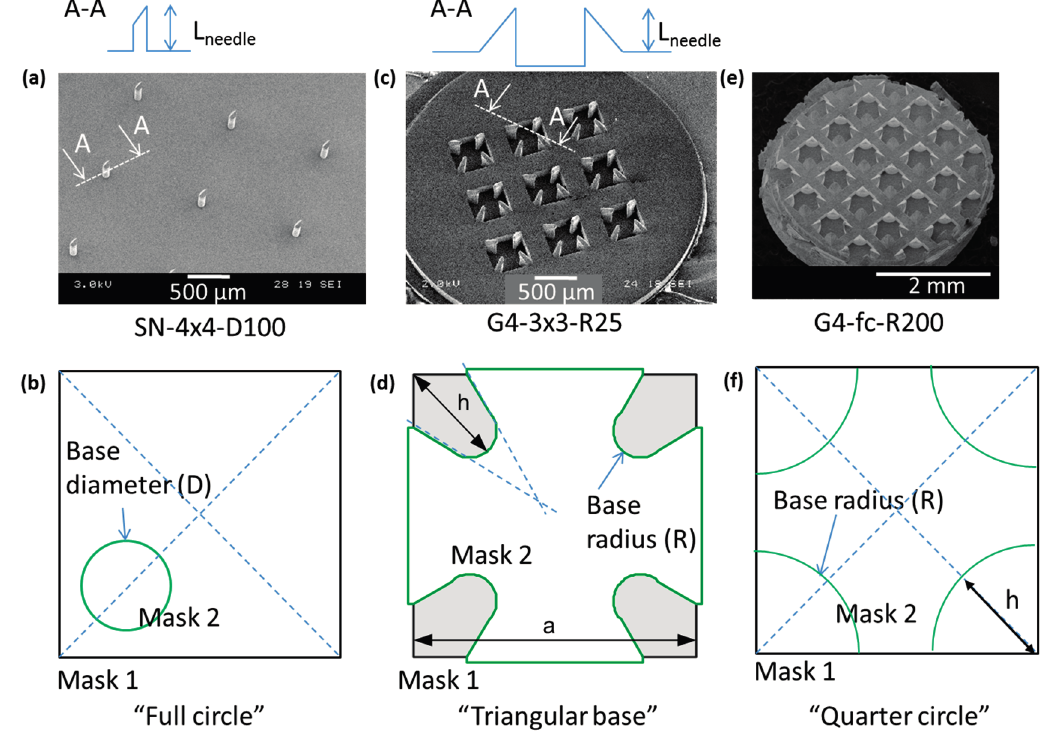
Figure 1. Cross-sectional schematic of the needle shapes, SEM images and mask designs of different nanoporous microneedle arrays (npMNAs) configurations. ( a , b ) Single Needle (SN) 4 × 4 npMNA with a base diameter (D) of 100 µm and a needle length ( L needle ) of 320 µm; ( c , d ) Triangular base groups-of-four (G4) MNs defined in three rows and columns with a microneedle (MN) base radius ( R ) of 25 µm and a needle length ( L needle ) of 200 µm; ( e , f ) Quarter circle G4 MNs with a MN base radius ( R ) of 200 µm and a needle length ( L needle ) of 200 µm fully covering the base plate; the cross-sectional schematic impression would be the same as given in ( c